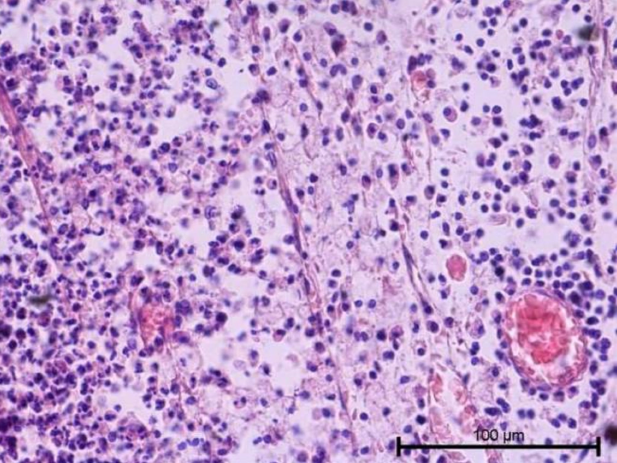
Figure 2. Light microscope image, human molar after extraction—Group II. Mild pulpitis. Visible neutrophilic infiltration and minor collapsed capillaries. HE stain. Mag. 200 ×